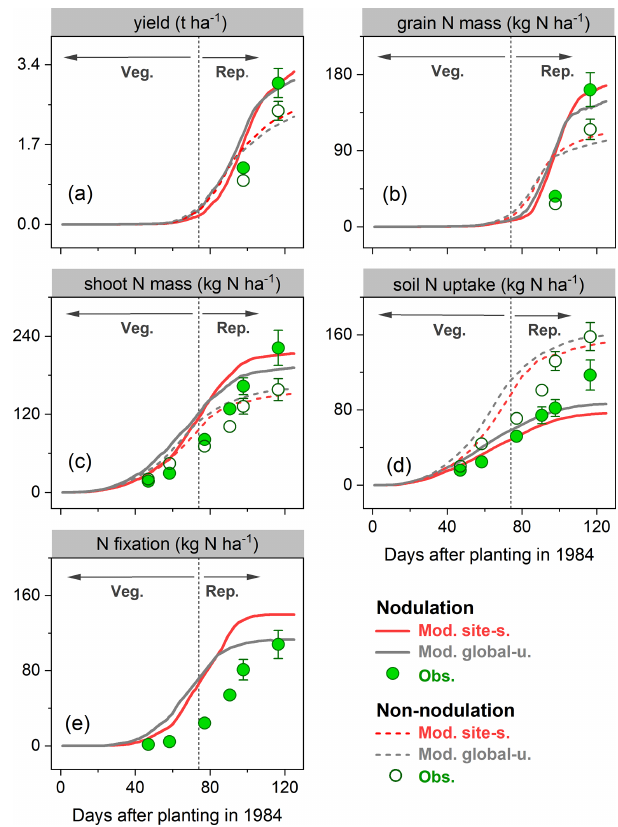
Figure 6. Observed (circles) and modeled (lines) yield (a) , grain N mass (b) , shoot N mass (c) , soil N uptake (d) , and BNF (e) for a field site in Austria (Zapata et al., 1987) for the cropping season 1984 with nodulating and non-nodulating soybean. The observed values of soil N uptake and BNF across all growth stages were calculated based on Fig. 1 given in Zapata et al. (1987), and the vertical bars represent the standard error of a four-replicate mean in the origi- nal literature. Veg. and Rep. indicate vegetative and reproductive growth phase,